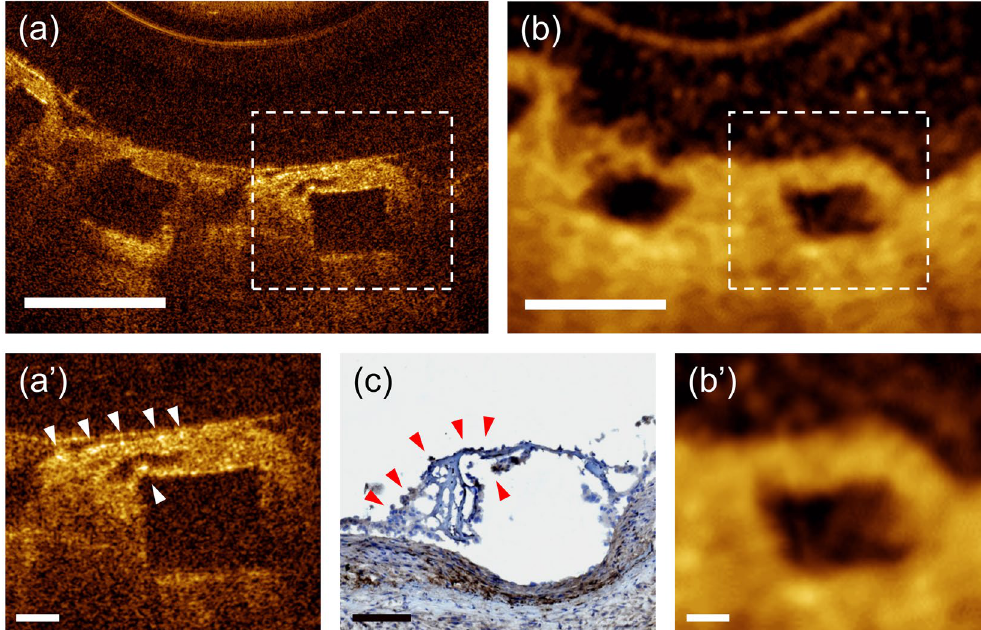
Figure 5. ( a ) Cross-sectional µ OCT image of the swine coronary artery with a BVS implanted 7 days prior to imaging; ( b ) Corresponding conventional OCT image; ( a’ ) A magnified µ OCT image shows the infiltrated macrophages (bright spots, white arrowheads) around struts; ( b’ ) Conventional OCT show neointimal tissue with relatively uniform signal intensity; ( c ) Corresponding anti-macrophage immunostaining findings corroborate the µ OCT imaging findings (red arrowheads). Scale bars for a and b , 500 μ m. Scale bars for a’ and b’ , 100 μ